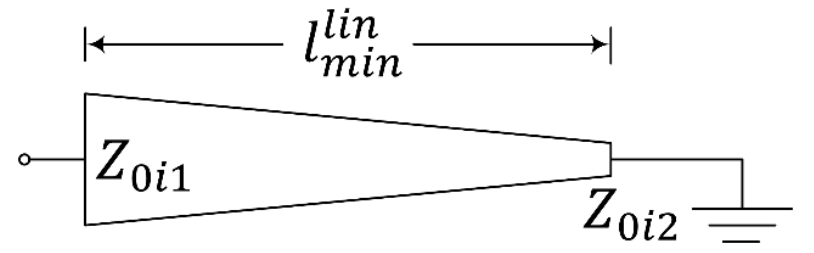
Figure 3. Linear TTL short-circuited stub. Table 1. Parameters of tapered stubs.